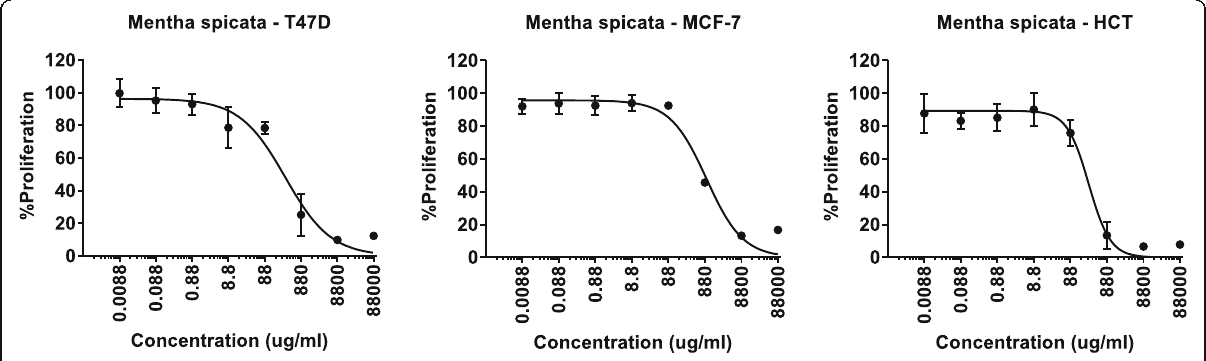
Fig. 1 Antiproliferative activities of aerial parts of M. spicate essential oil on three cancer cell lines, exposure time 48 h